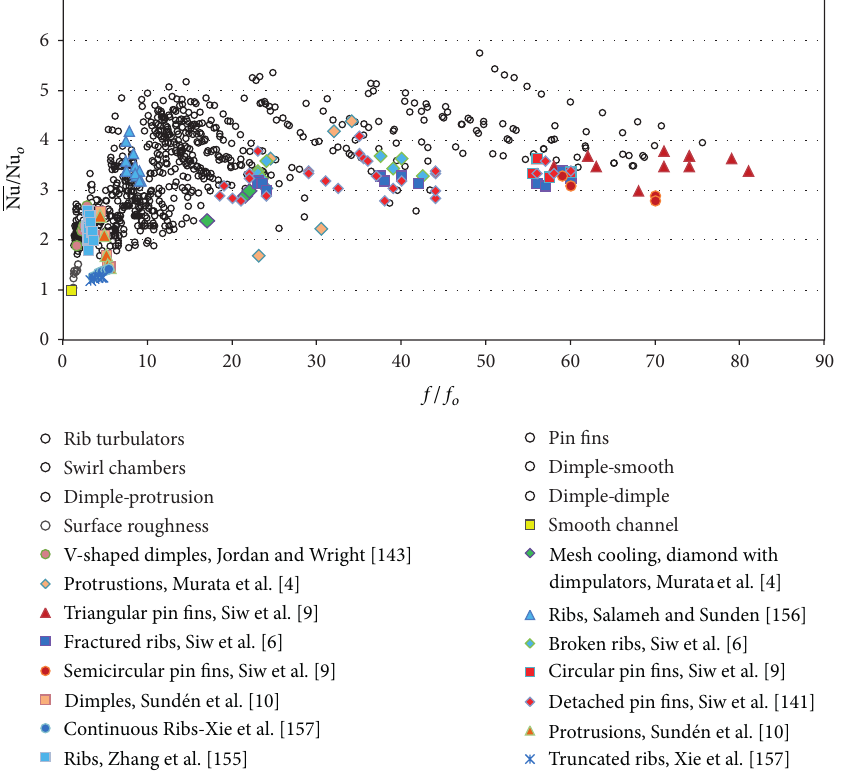
Figure 18: Comparison of relative performance of rib turbulators, pin fins, swirl chambers, dimple-smooth arrangements, dimple-protrusion arrangements,dimple-dimplearrangements,surfaceroughness,andsmooth-walledchannels,includingresultsfrominvestigationsafter2003. Globally averaged Nusselt number ratios Nu / Nu 𝑜 are presented as dependent upon friction factor ratios 𝑓/𝑓 𝑜